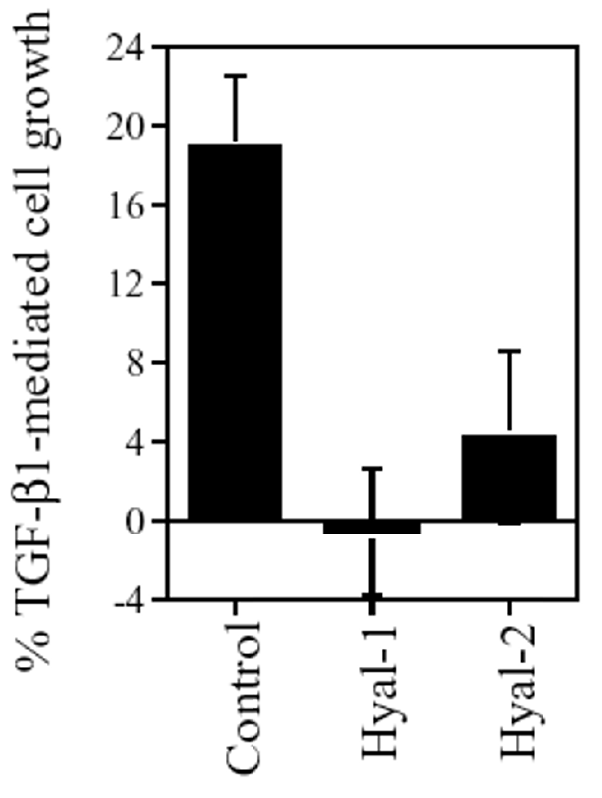
Figure 6 TGF- β 1 promotes L929 cell growth but not the growth of Hyal-1 and Hyal-2-expressing L929 cells. Non-transfected L929 cells or the stable GFP-Hyal-1 and GFP-Hyal-2-express- ing cells were treated with TGF- β 1 (2 ng/ml) for 24 hr. The extent of cell growth was measured by staining the cells with crystal violet (mean ± standard deviation; n = 8).